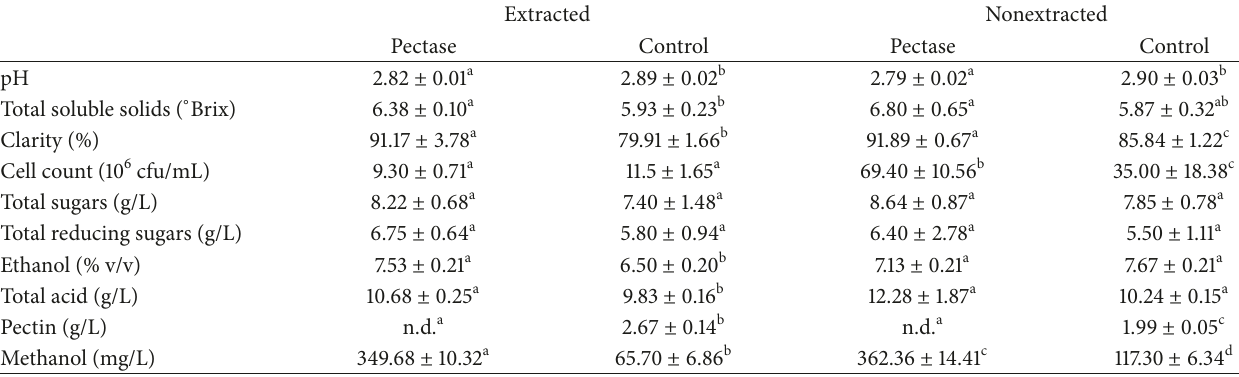
Table 1: Physicochemical properties and total reducing sugar concentration of extracted and nonextracted wine, with and without pectase